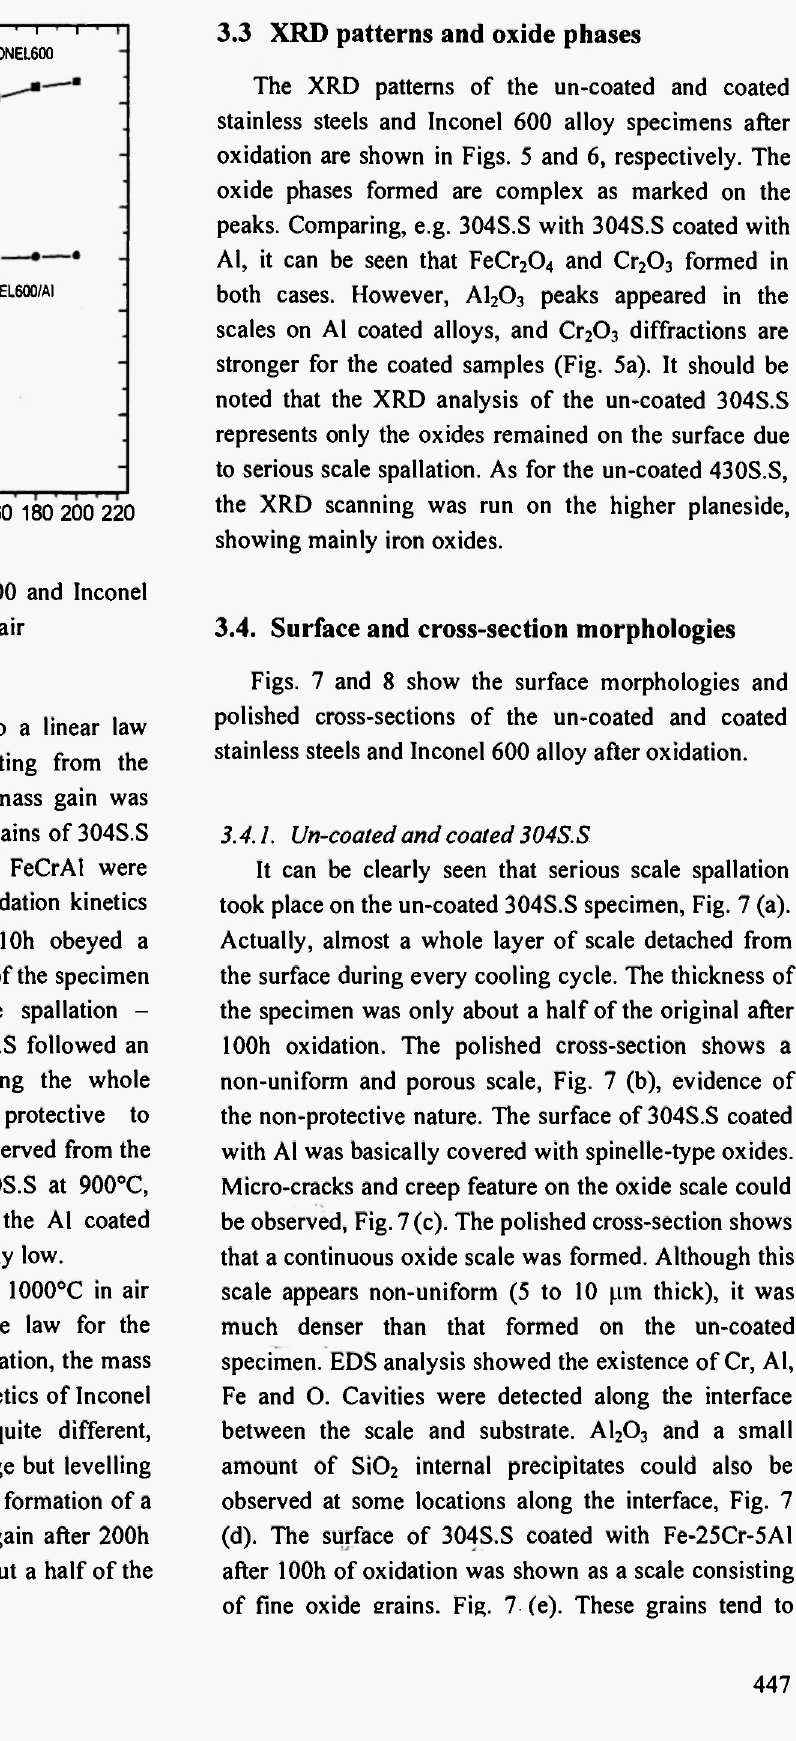
Fig. 4: Oxidation kinetics of Inconel 600 and Inconel 600 coated with Al at 1000°C in air